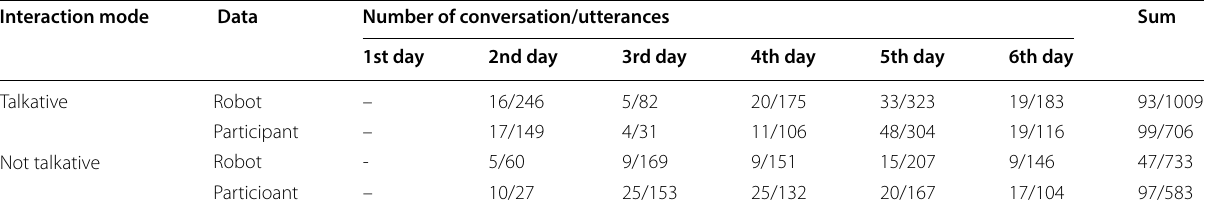
Table 5 Number of conversations and utterances by speaker Interaction